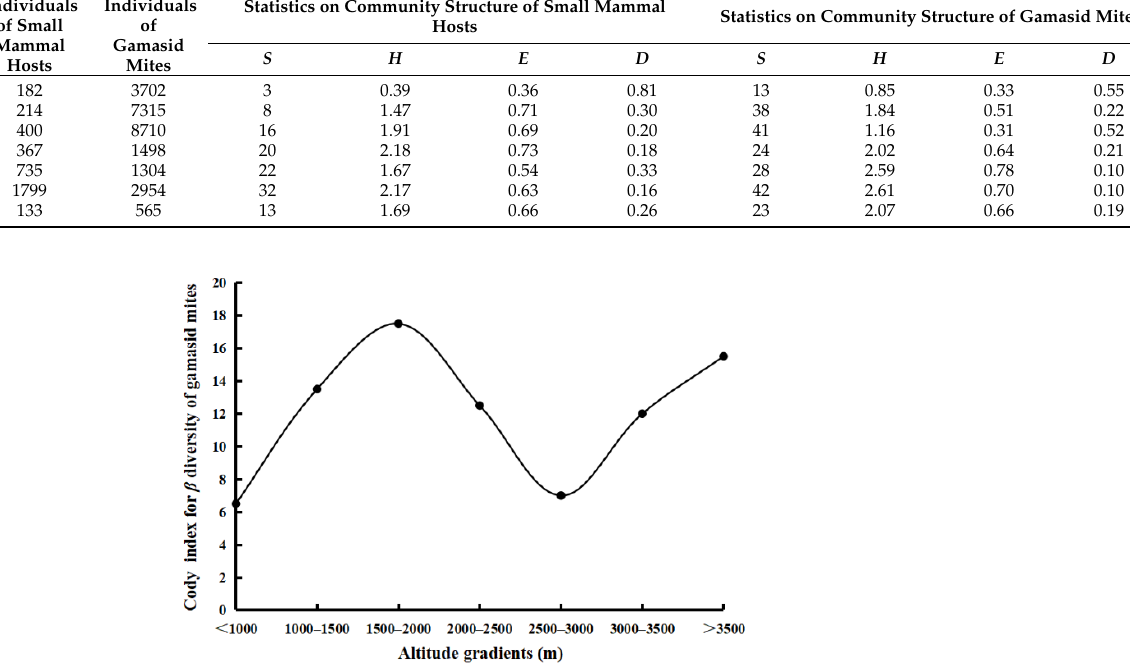
Figure 3. Variations of β diversity of gamasid mites along altitude gradients in Three Parallel Rivers Area in northwest Yunnan of China (2001 – 2015).